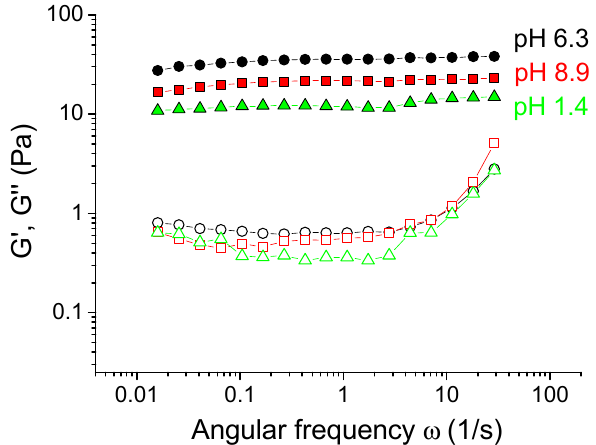
Figure 7. Frequency dependences of storage G ʹ ( fi lled symbols) and loss G” (open symbols) moduli for 0.1 wt % xanthan aqueous solutions in the presence of 0.017 wt % CrCl 3 corresponding to the molar ratio [CrCl 3 ] / [xanthan monomer units] = 1: prepared at pH 6.3 (circles); obtained by the addition of 150 µ L of 5 M HCl to the 4 mL gel initially prepared at pH 6.3 (triangles); obtained by the addition of 4.5 µ L of 5 M KOH to the 4 mL gel initially prepared at pH 6.3 (squares).